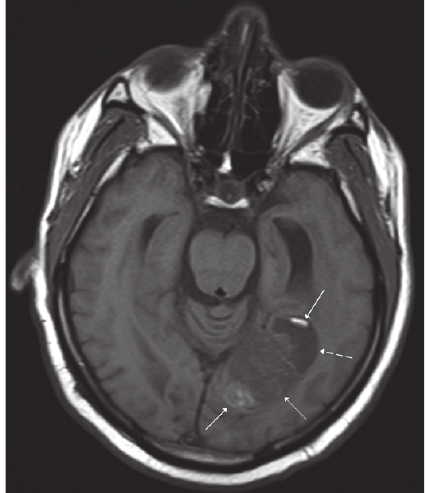
Figure 2: Precontrast axial T1 weighted image shows the solid component (dotted white arrows) to be hypointense to grey matter with small areas of T1 hyperintensity (solid white arrows) seen peripherally within the cystic (dashed white arrow) and solid components, likely representing areas of focal hemorrhage.